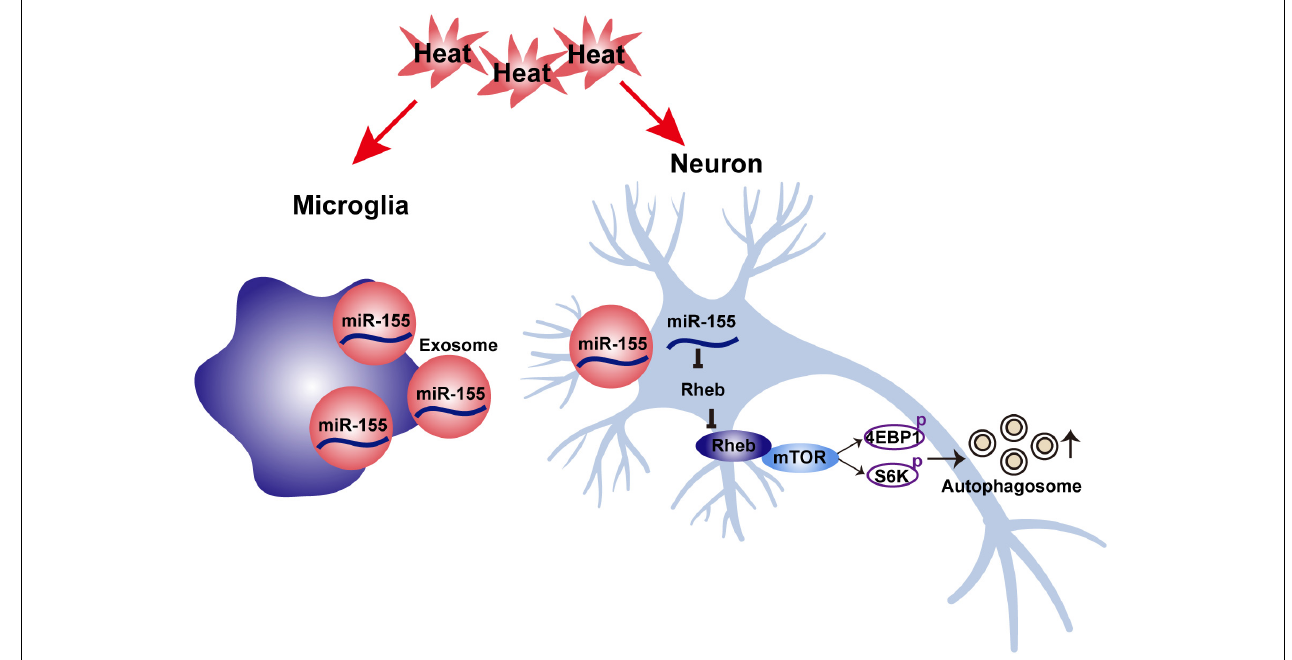
FIGURE 8 | Schematic illustration of the mechanism underlying the effects of microglia-derived exosomal miR-155 on neuronal autophagy after heat